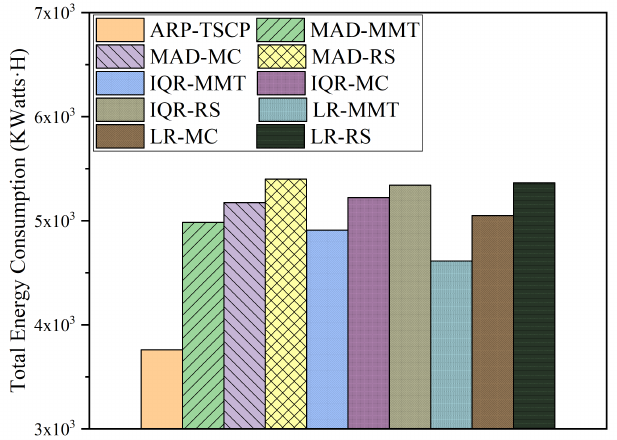
Figure 11. Comparing the total energy consumption hosts by all